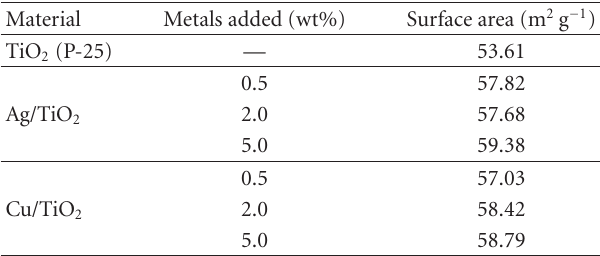
Table 2: Surface area of P-25 TiO 2 , 5% Ag/TiO 2 and 5% Cu/TiO 2 .